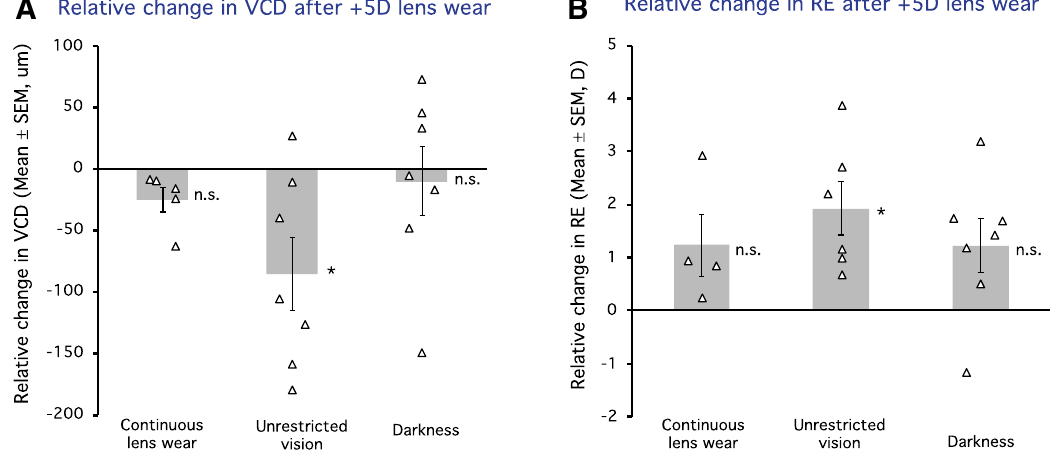
Figure 3. The relative change (the change in the lens-wearing eye relative to the change in the fellow eye) in vitreous chamber depth (VCD, A ) and refractive error (RE, B ) after wearing + 5D lenses for 4 weeks, either continuously or with interruptions. Triangles show individual animals, and bars represent the average for each group. RE was measured in 4 out of the 5 animals for the control group, and in 6 out of 7 animals for the group with unrestricted vision. n.s. Not significant; *p < 0.05.